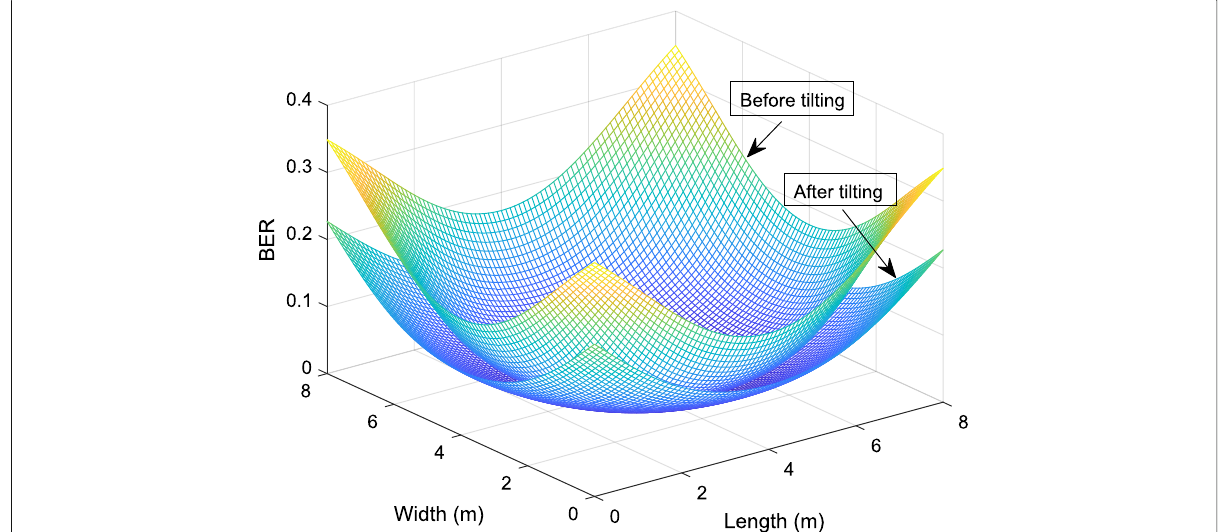
Fig. 8 BER distributions before and after tilting the receiver plane in the whole